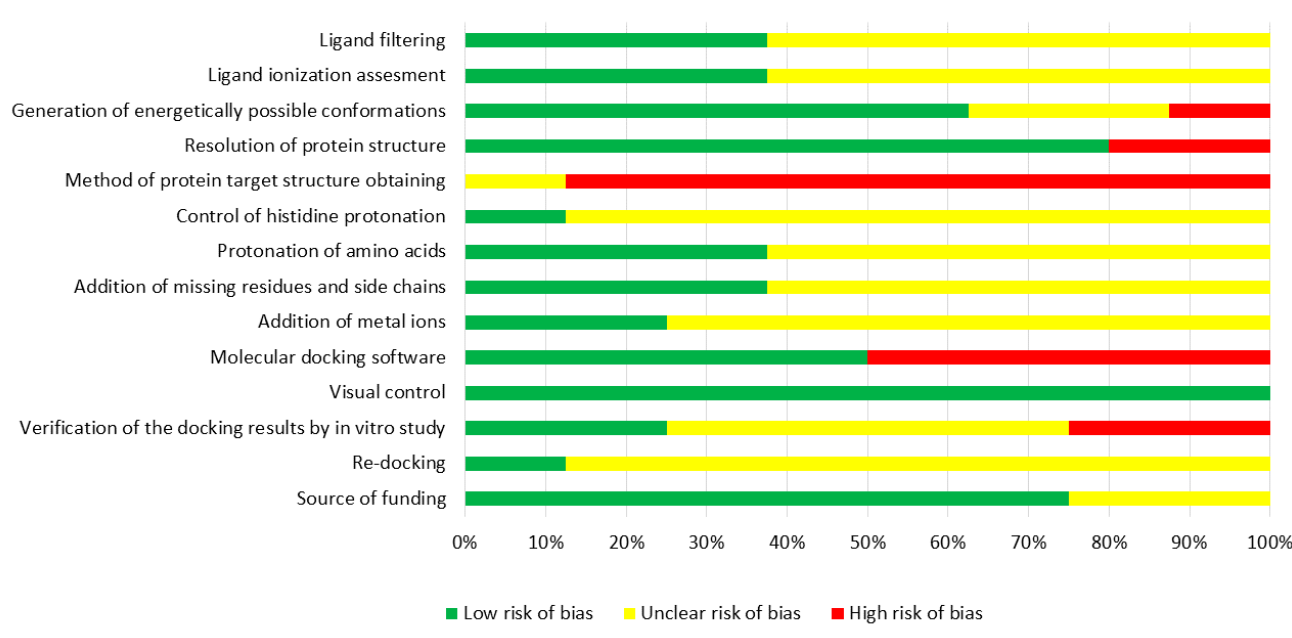
Figure 5. Risk of bias graph.